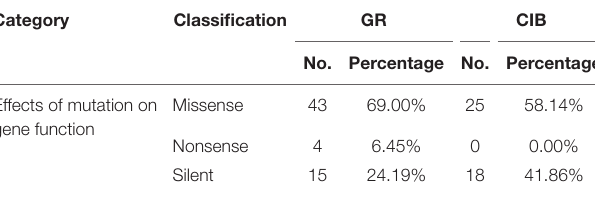
TaBLe 4 | The predicted effects of mutations on gene function.